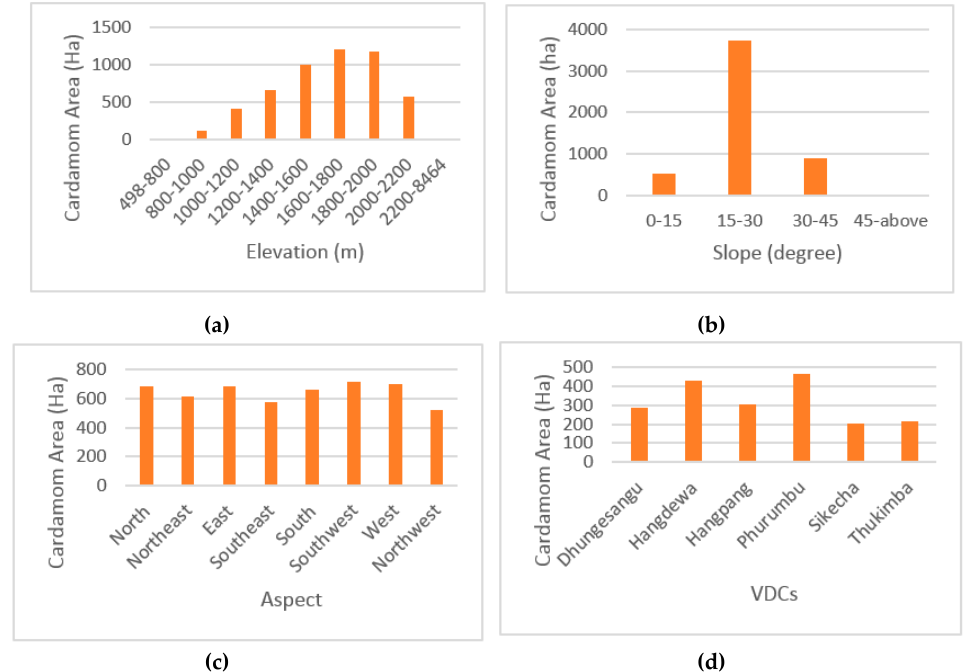
Figure 5. Analysis of large cardamom cultivation area based on elevation, slope, aspect, and VDCs. ( a ). Cardamom cultivation area with elevation; ( b ). Cardamom cultivation area with slope; ( c ). Cardamom cultivation area in various aspects; ( d ). Top 6 VDCs with the highest cultivation area.